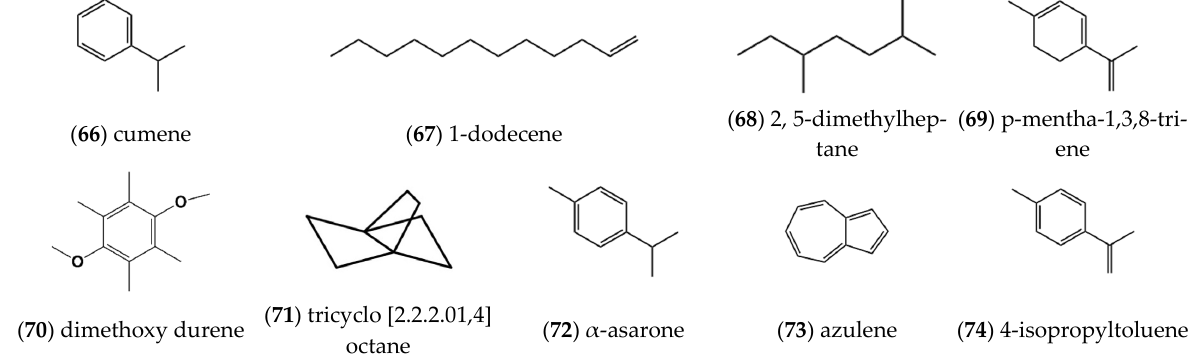
Figure 6. Structures of alkanes isolated from ST .